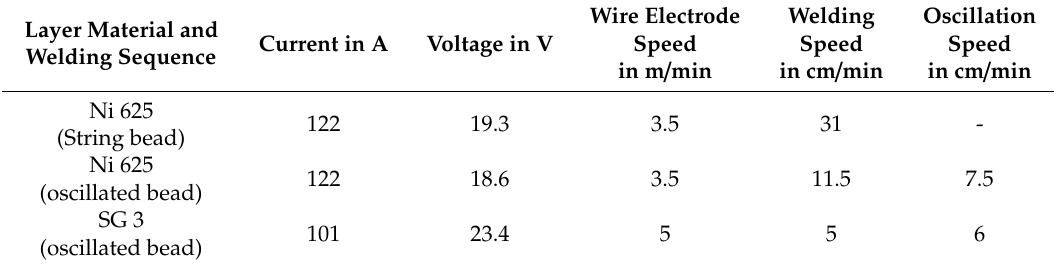
Table 5. Welding parameters for dilution controlled specimens.